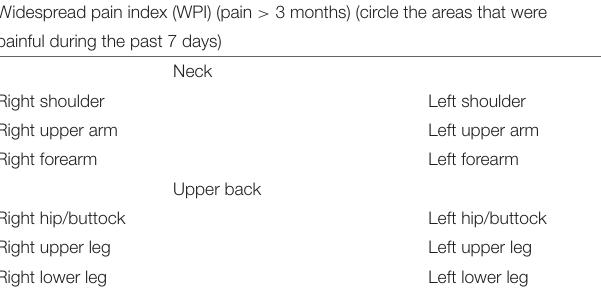
TABLE 3 | ACR 2010 diagnostic criteria, revised in 2016. Widespread pain index (WPI) (pain > 3 months) (circle the areas that